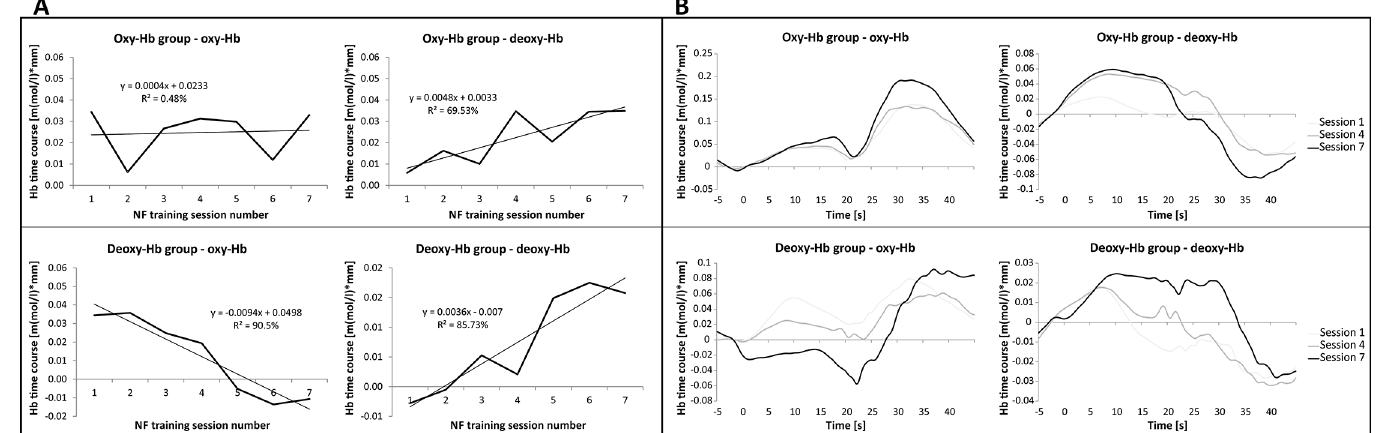
Fig 3. NIRS NF training performance. A) NF training performance (relative concentration changes in oxy- and deoxy-Hb over the bilateral inferior frontal gyrus during the NF training task, average second 5 to 20 after task onset) over the seven NF training sessions and the results of the regression analysis, presented separately for the oxy-Hb group (upper panel) and deoxy-Hb group (lower panel). B) NIRS time course during the first, fourth and last NF training session averaged for NIRS channels over the bilateral inferior frontal gyrus, presented separately for both groups. Note that the NF training task started at second 0 and ended after 17 – 23